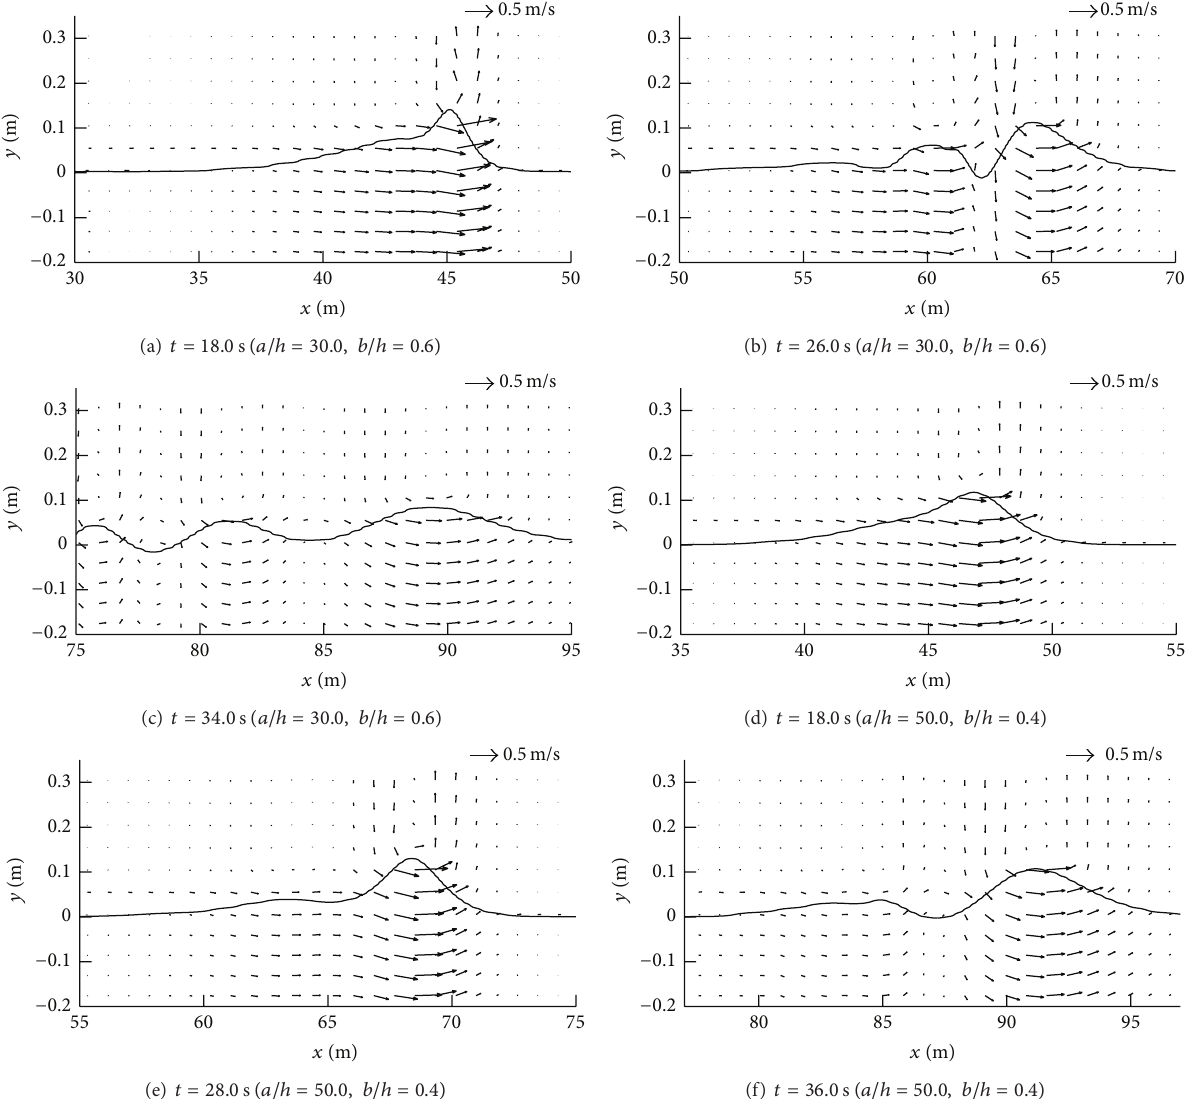
Figure 8: Variation in velocity distributions for solitary waves over a submerged